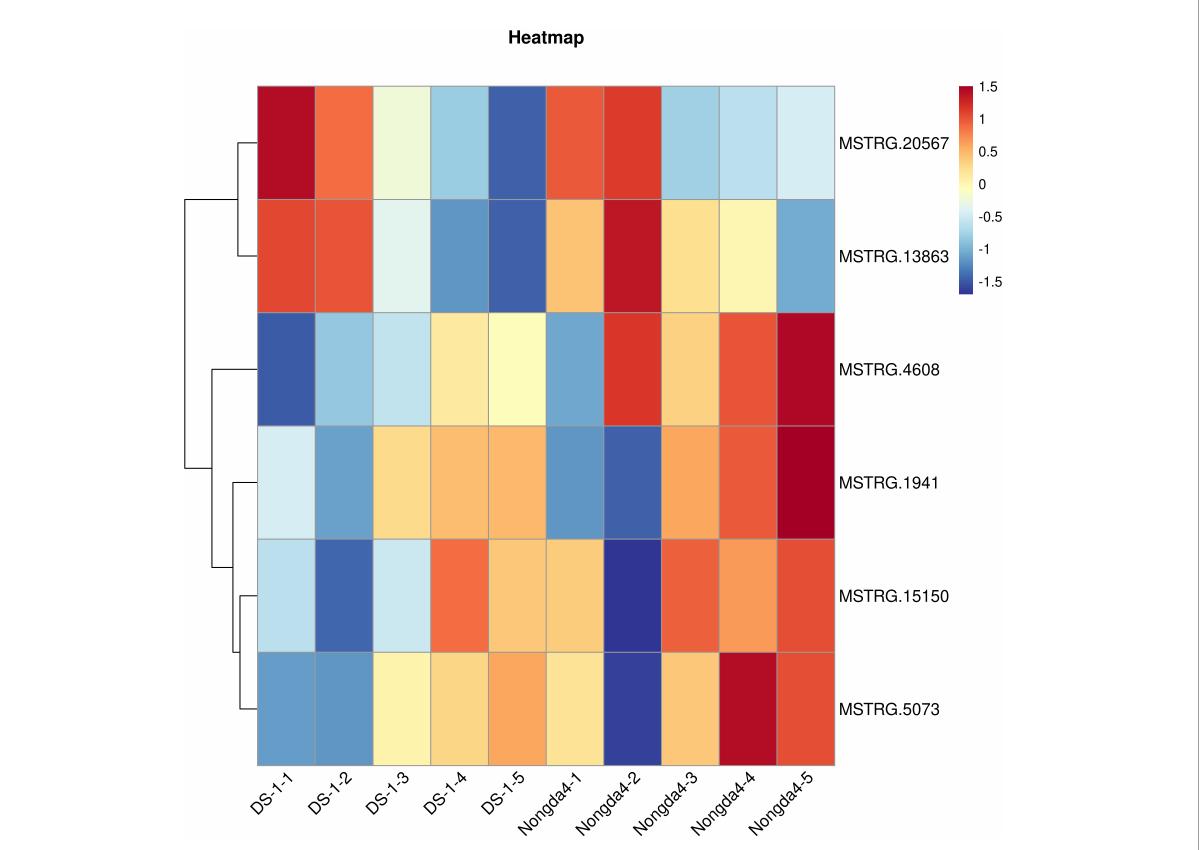
FIGURE3 Heatmap of the expression of key genes. Red boxes represent high expression and blue boxes represent low expression. DS-1-1, DS-1-2, DS-1-3, DS-1-4, DS-1-5, Nongda4-1, Nongda4-2, Nongda4-3, Nongda4-4, and Nongda4-5 indicate DS-1 and Nongda4 fruits at S1, S2, S3, S4, and S5 developmental stages, respectively.